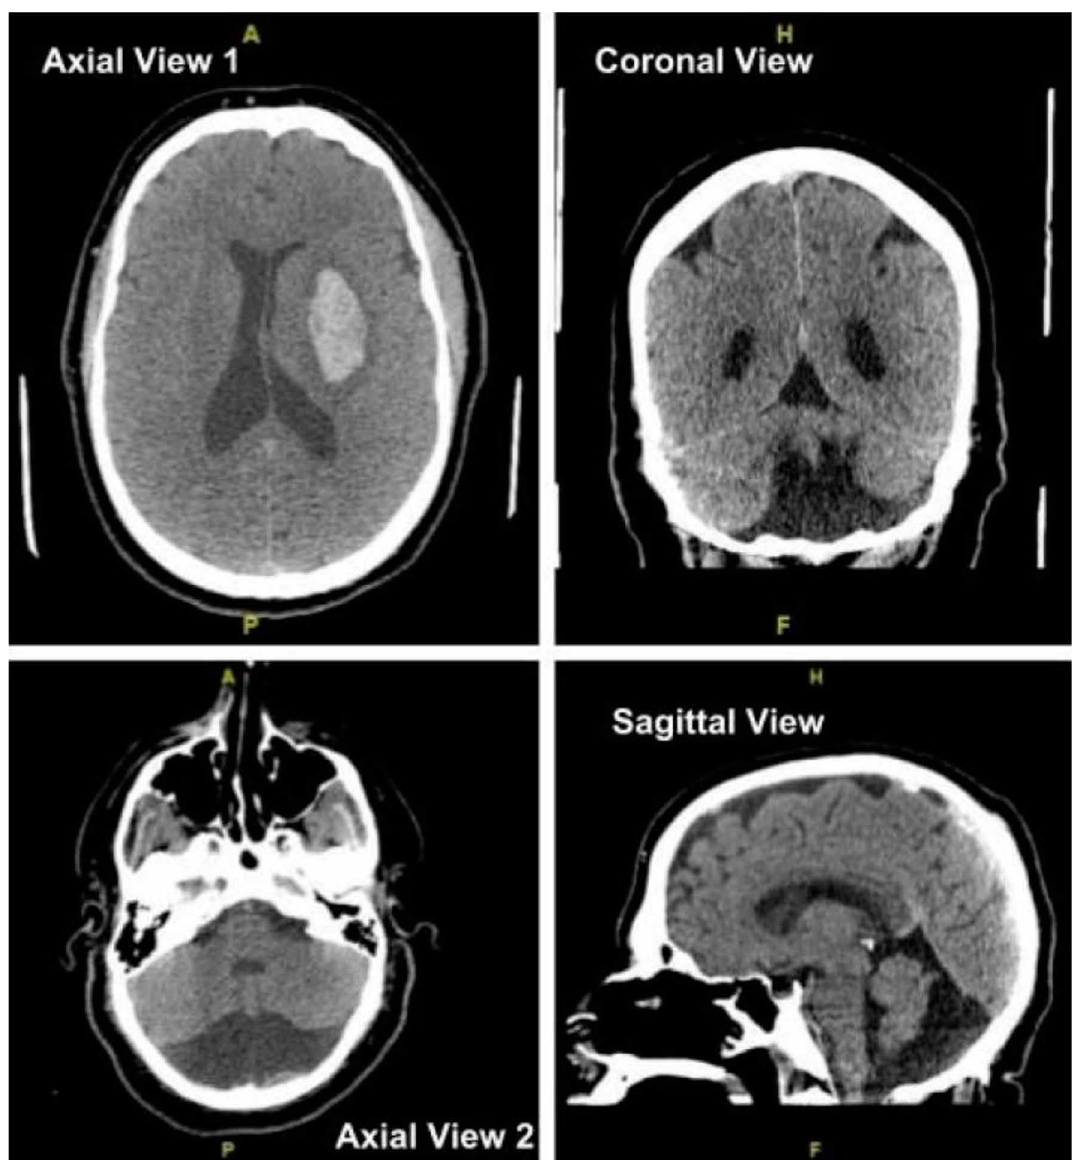
Figure 1: CT studies obtained upon arrival revealing left basal ganglia hemorrhage in axial view 1 and absence of the cerebellum consistent with DWM in coronal view, axial view 2 and sagittal